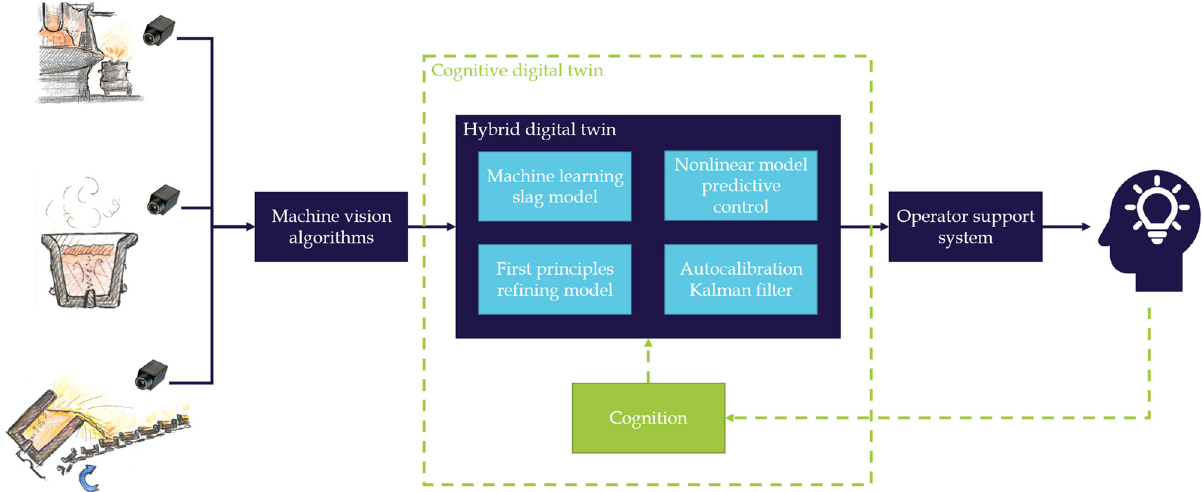
Figure 4: A fl owchart for the hybrid digital twin. A thermal camera is observing each part of the process, tapping, re fi ning and casting. The thermal imagine data are processed by a set of machine vision algorithms before being used by the hybrid digital twin. The optimized results from the hybrid digital twin are shown to the operators via a graphical operator support system.